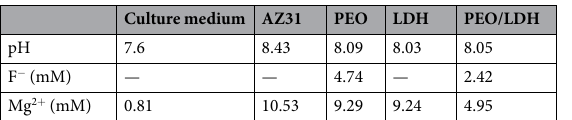
Table 3. The pH value, concentration of F and Mg ions of the extracts and culture